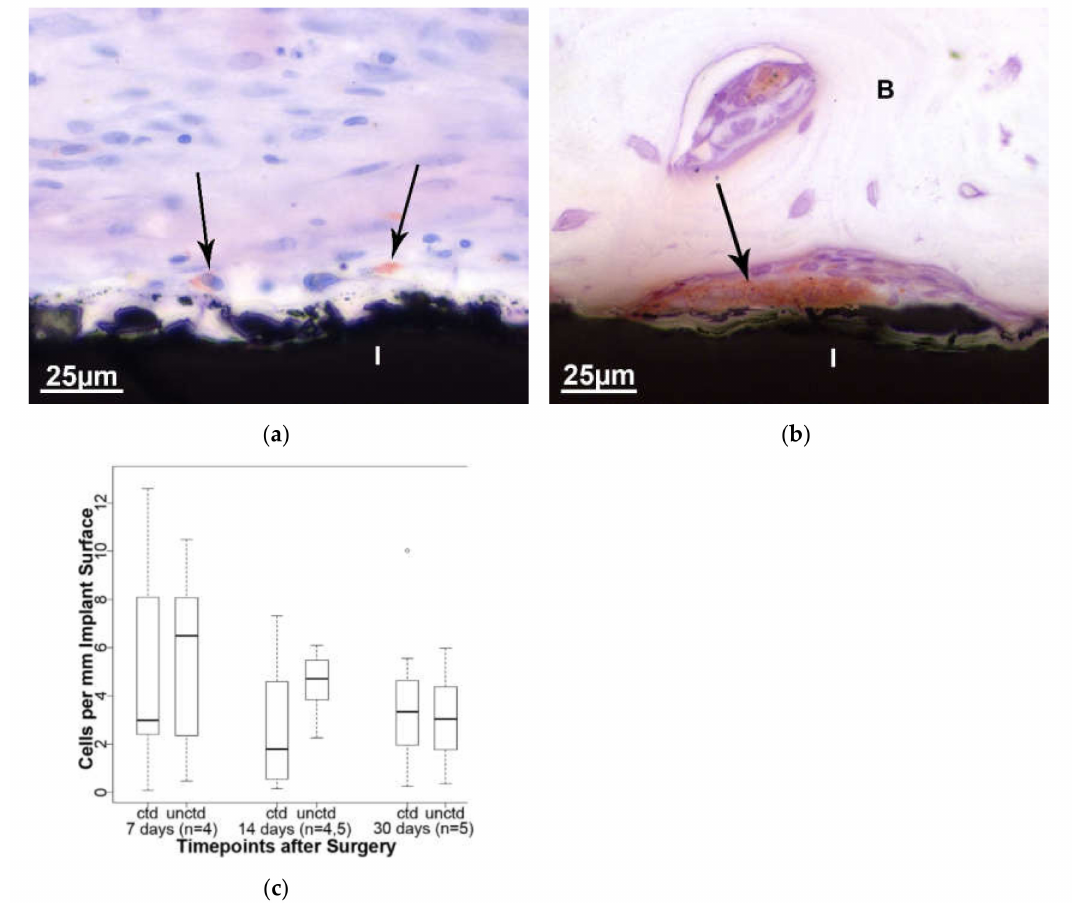
Figure 8. Mononuclear and multinucleated cells stained with ED1 (arrow) are visible on the surface of the implant (I) ( a , 14 days, coated and b , 30 days, uncoated). ( c ) Comparing the number of